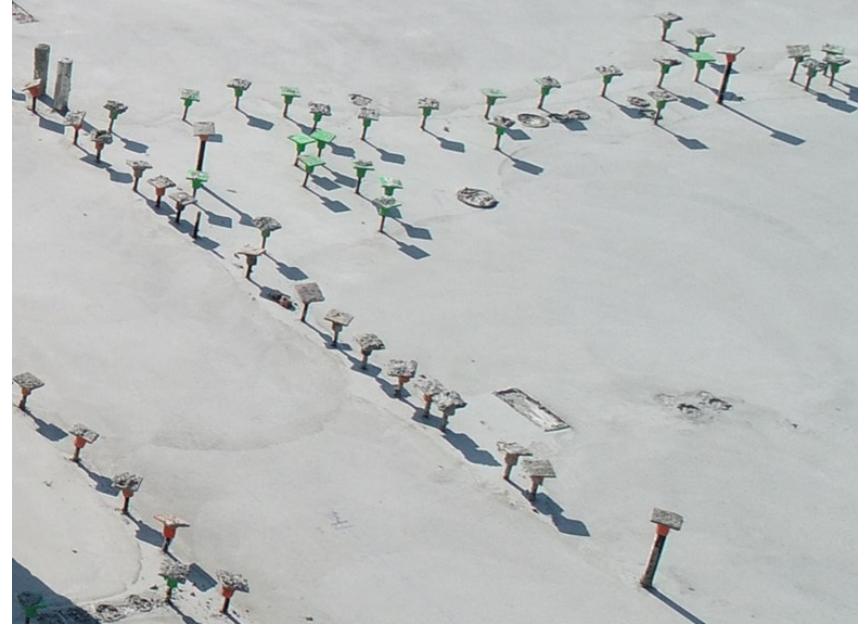
Figure 12. Protruded rebar ends covered with caps for safety (adapted and used with permission from Blake [41]).